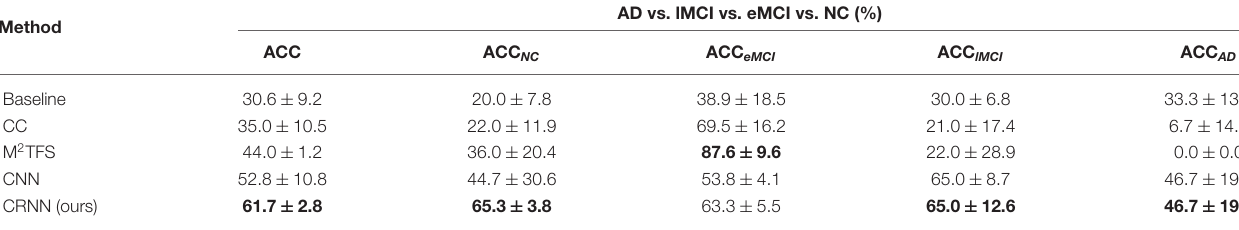
TABLE 3 | Performance of five methods in the multi-class classification task, i.e., AD vs. lMCI vs. eMCI vs. NC classification.